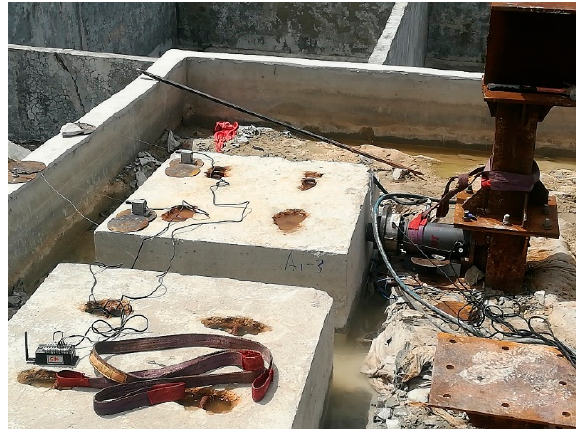
Figure 8. Horizontal jack loading of Hc specimen.